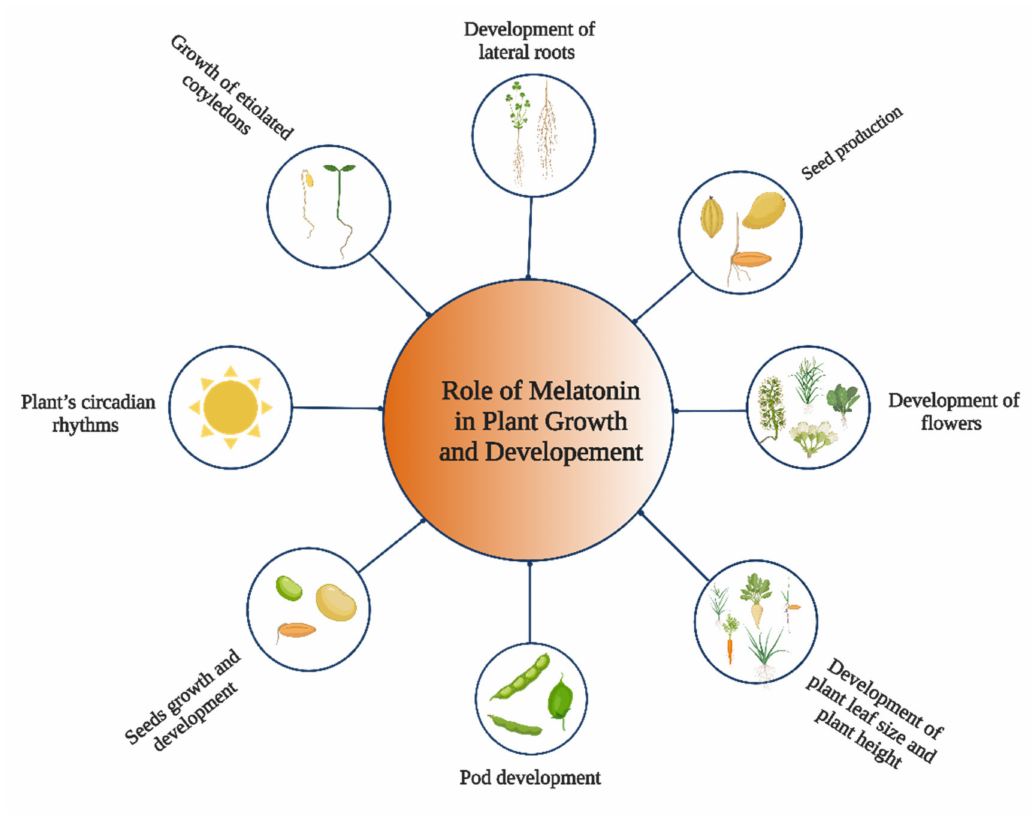
Figure 2. Role of melatonin in plant growth and development. This figure was created with BioRen- der.com (accessed on 7 September